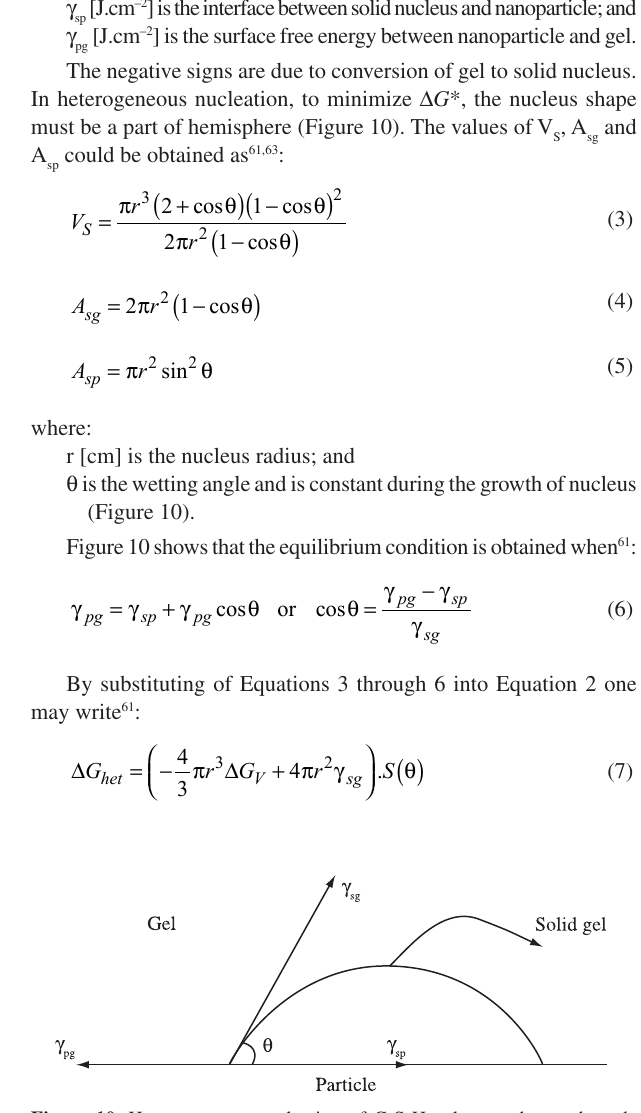
Figure 10. Heterogeneous nucleation of C-S-H gel upon the sands and